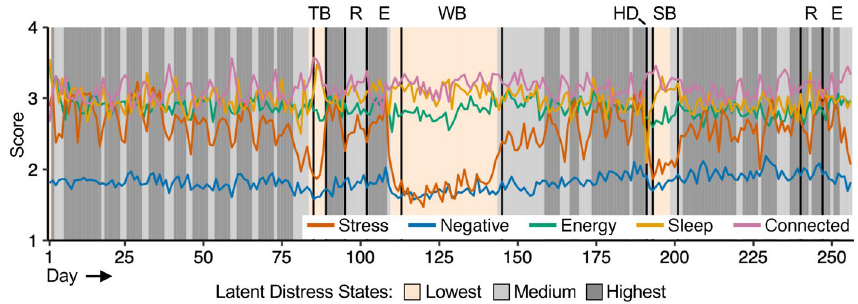
Figure 3. Latent states of distress reflect the structure of the academic calendar. Latent states were estimated via multivariate hidden Markov modeling over the group mean time series of stress, Negative affect, Energy, Sleep quality, and feeling Connected to others. TB thanksgiving break, R reading period, E exams period, WB winter break, HD housing day, SB spring